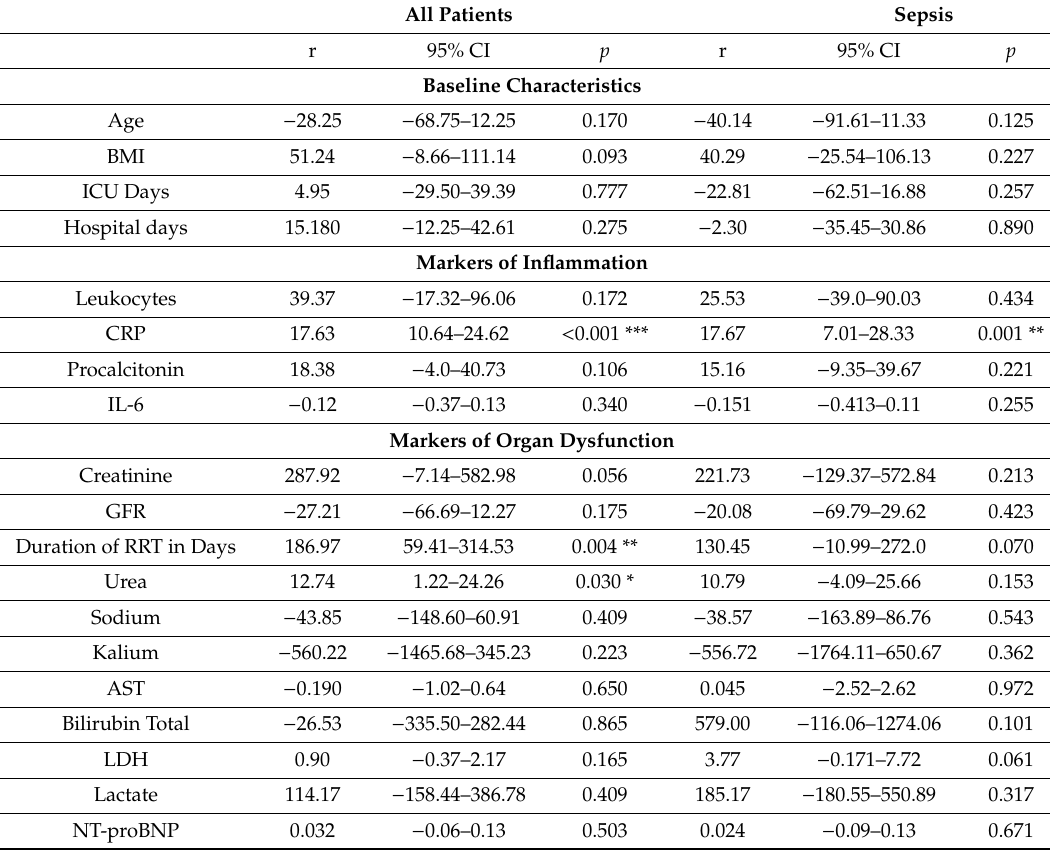
Table 2. Linear regression analysis of calprotectin with baseline characteristics, markers of inflammation, markers of organ dysfunction, other laboratory markers, and clinical scores at day 1 of ICU admission. All